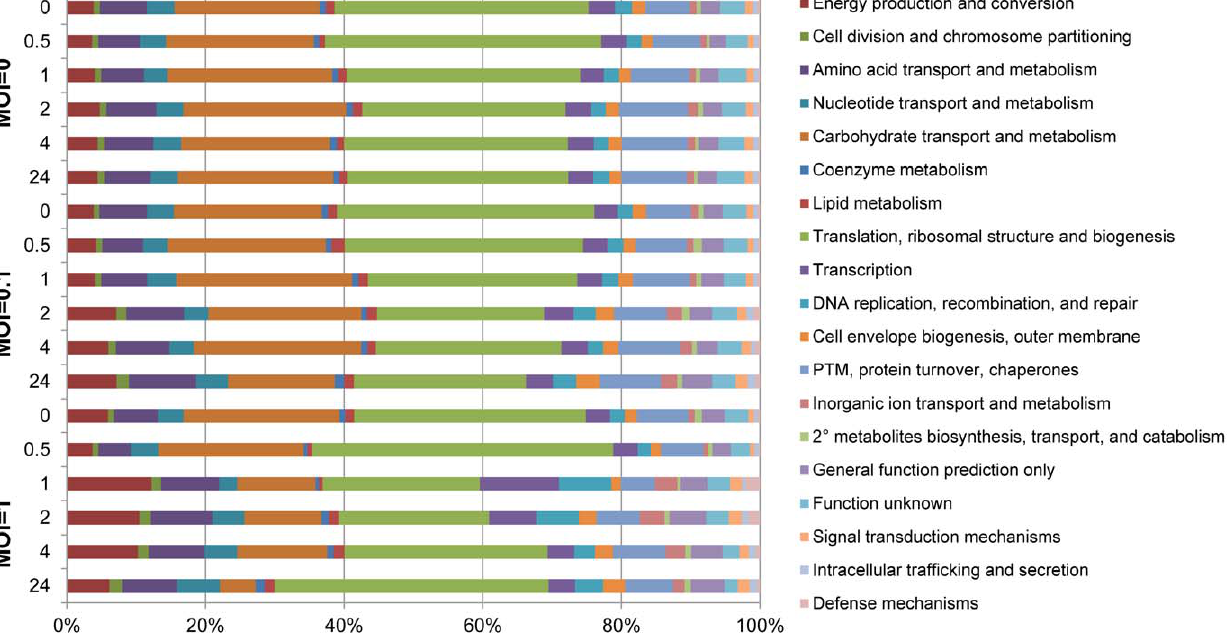
Figure 2. COG classification of S.thermophilus proteomes across infection time points. Proteins were grouped into functional categories by COG assignments. Percentages were calculated using normalized spectral counts averaged between two technical replicates. doi:10.1371/journal.pone.0038077.g002 PLoS ONE |